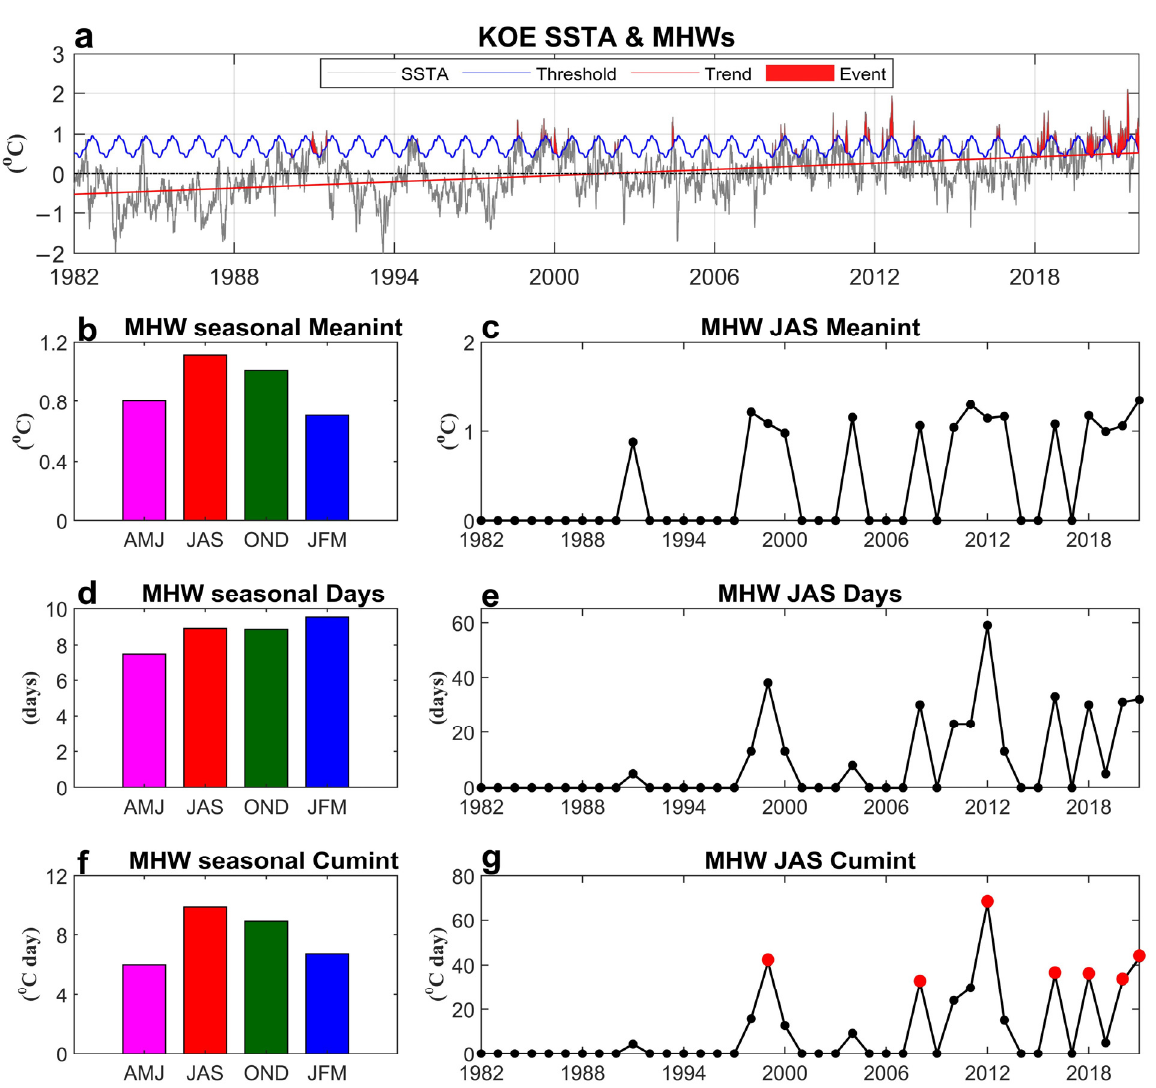
Figure 3. ( a ) Times series of daily SSTA (black line) averaged over the KOE region and the MHWs (red shading) detected using the 90th percentile threshold (blue line). Anomaly is relative to the 1982–2021 climatology and the red line denotes the linear trend. ( b ) The mean intensity (Meanint) of MHWs in different seasons; ( d , f ) same as ( b ), but for average total days (Days) and average cumulative intensity (Cumint); ( c ) The JAS averaged MHW mean intensity; ( e , g ) same as ( c ), but for total days and cumulative intensity. Red dots in ( g ) indicate the seven MHWs with the highest cumulative intensity in JAS.